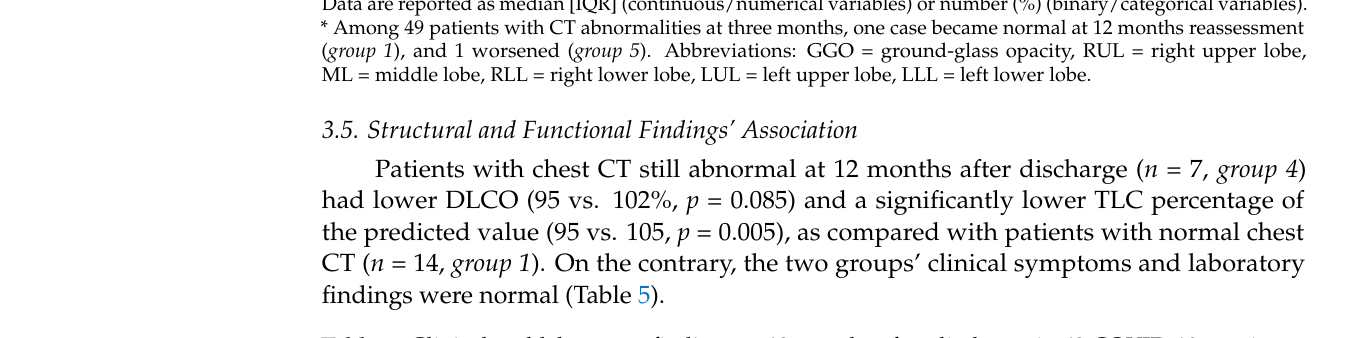
Table 5. Clinical and laboratory findings at 12 months after discharge in 63 COVID-19 survivors, subdivided by chest CT findings at 12 months: normal (CT-) vs. abnormal